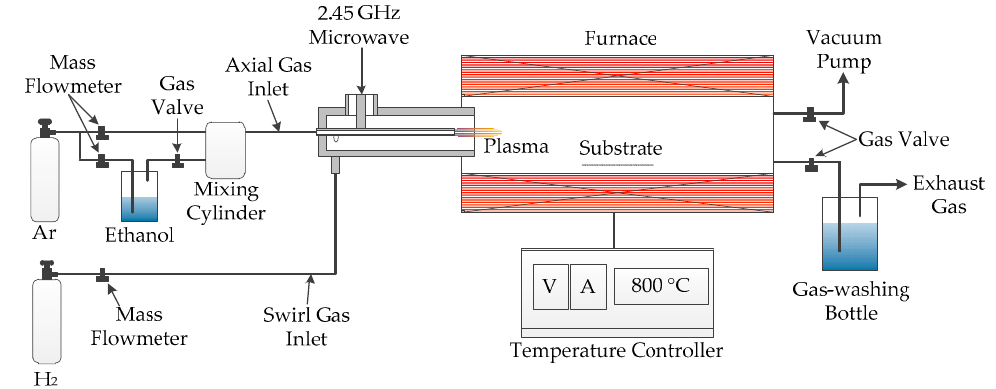
Figure 1. The diagram of atmospheric pressure microwave plasma chemical vapor deposition (AMPCVD) for carbon nanotubes’ (CNTs) growth on aluminum foil with the ethanol precursor.